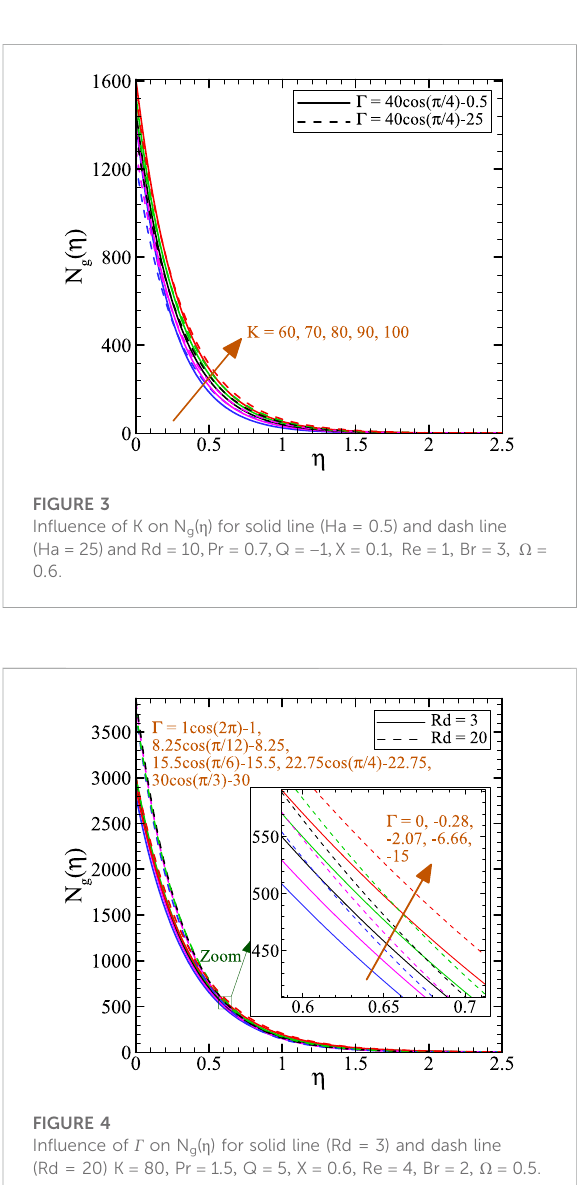
FIGURE 6 In fl uence of Q on N g ( η ) for solid line ( α (cid:3) 0 o ) and dash line ( α (cid:3) 90 o ) and K (cid:3) 70 , Ha (cid:3) 5 , Λ (cid:3) 5 , Rd (cid:3) 20 , Pr (cid:3) 2 , X (cid:3) 0 . 1 , Re (cid:3) 5 , Br (cid:3) 5 , Ω (cid:3) 0 .